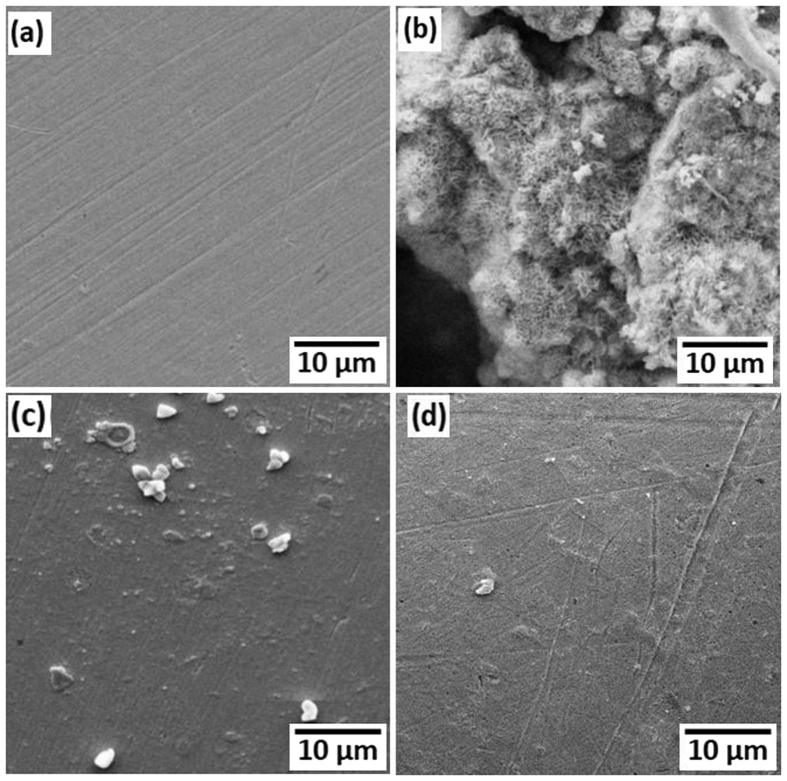
SEM images of (a) plain MS surface, (b) MS in 0.5 M H2SO4, (c) MS in 0.5M H2SO4+ 1600 ppm PNVP-PU, and (d) MS in 0.5M H2SO4 + 1600 ppm PDMAEMA-PU.